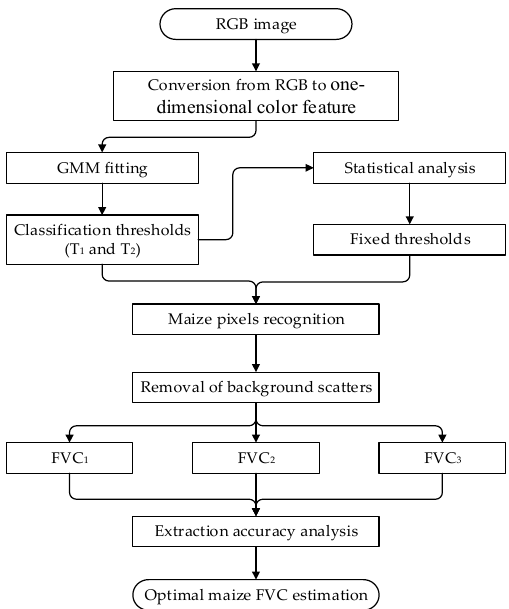
Figure 2. The procedure to estimate maize fractional vegetation cover (FVC) using three different threshold-based methods based on RGB images.